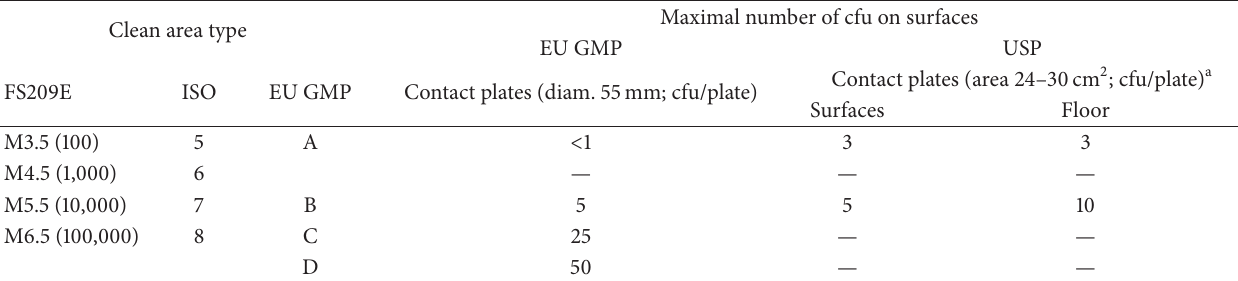
Table 7: Recommended limits for viable airborne particles on surfaces according to EU-GMP and USP. Clean area type